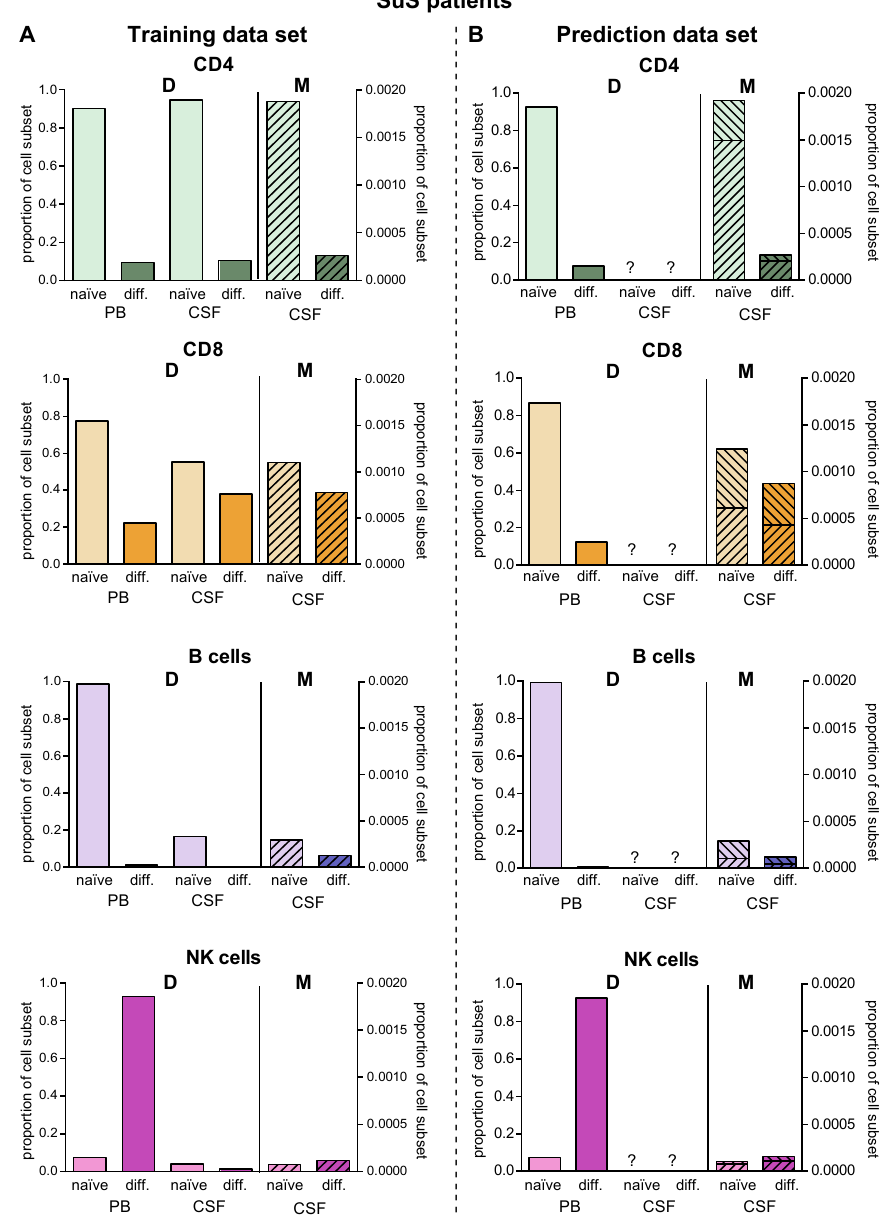
Figure 6. Validation of the model. ( A ) Comparison of data (D, Table S1) showing frequencies of naïve (light colors) and di ff erentiated (dark colors) lymphocyte subsets from patients with SuS ( N = 14)